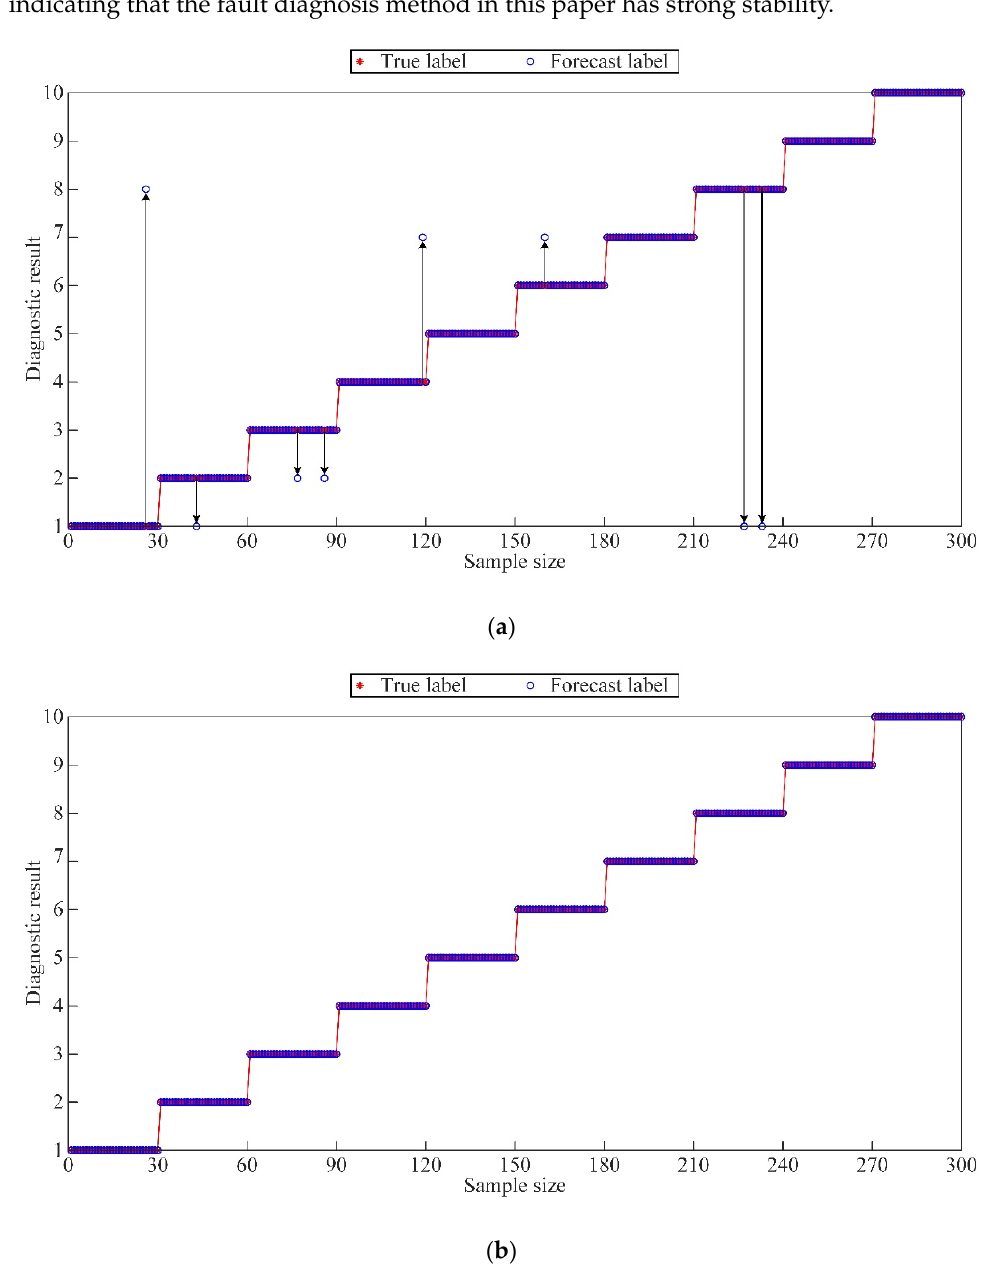
Figure 10. Fault diagnosis results of different methods, ( a ) VMD-SVM, ( b ) WGWOA-VMD-SVM.